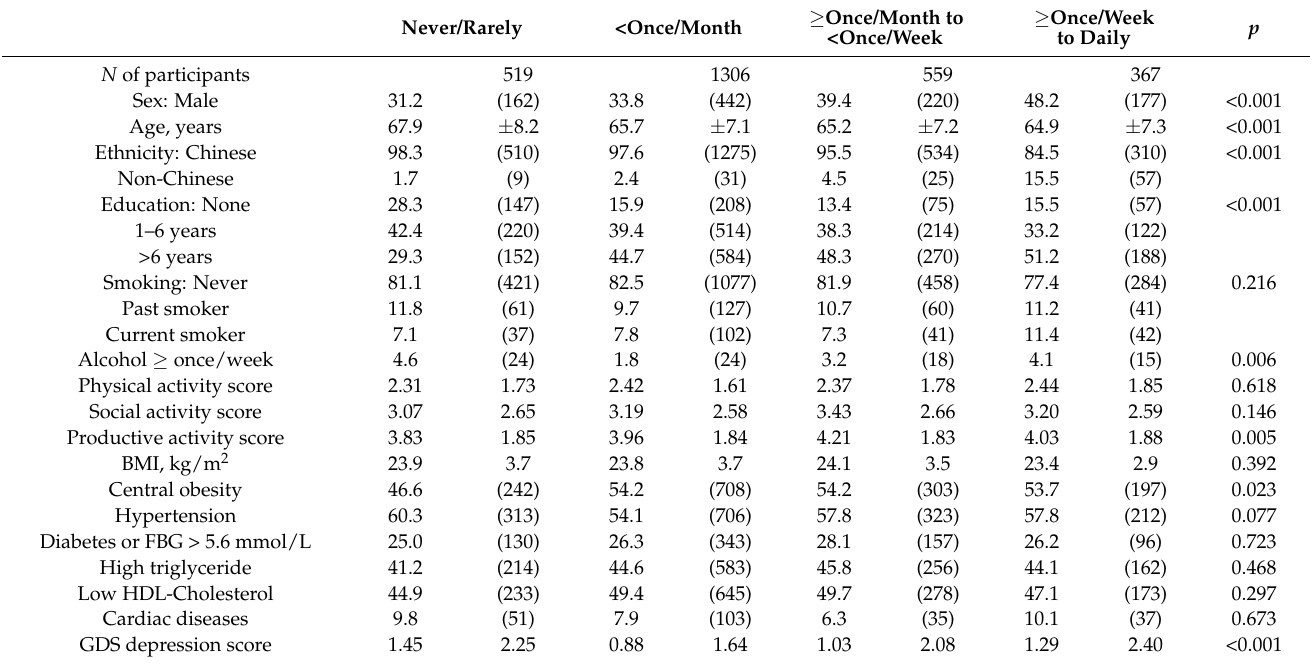
Table 1. Baseline characteristics of SLAS participants ( N = 2751) by curry consumption